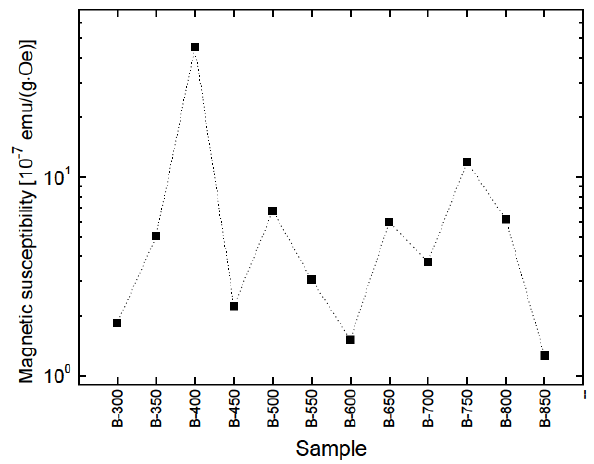
Figure 2: Temperature-independent component χ 1 of dc magnetic susceptibility in all investigated samples measured in FC mode in H = 100 Oe.